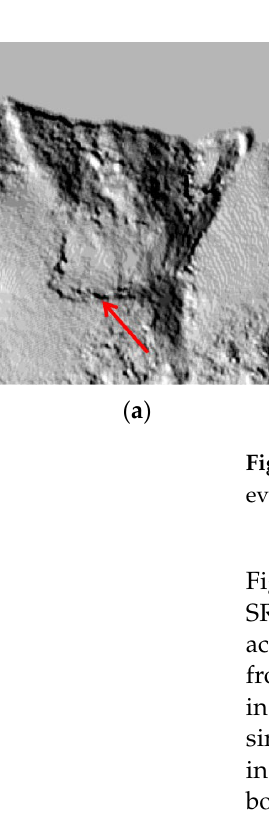
500600 Figure 14. Annual precipitation level (in mm) according to Sektagli meteorological data. A connection between the intra-annual displacement rates and the level of precipita- tions is illustrated in Figure 15. Increased movement rates measured on the interferograms -15 June 2016–13 July 2016 and 22 March 2017–15 November 2017 (last two points in Figure 10) may be ex- plained by the fact that the respective periods between acquisitions of the images, consti- tuting interferometric pairs, explicitly cover summer seasons with intensive rainfalls (red lines with numbers 1 and 2, respectively, in Figure 15). Short rainy interval 1 in the sum- mer of 2016 is an interval between ALOS-2 observations on 15 June 2016 and 13 July 2016. Additionally, a long and rainy summer interval in the summer of 2017 is an interval be- tween ALOS-2 observations on 22 March 2017 and 15 November 2017. An arrow number 3 in Figure 15 marks the start of the Sentinel-1 SAR observations in winter 2016–2017 (left plot in Figure 7). An absence of any significant rainfall for about two months before the start of the data collection is probably the reason for the uniform rates of soil movement throughout the winter. At the same time, the following winter measurements started on 9 November 2017, very close to the end of summer rainfalls (ar- row number 4 in Figure 15). Water-rich soils that time demonstrate increased velocity here, up to 17 cm per month; the velocity gradually decreased during the next two months to the average typical values of 4–5 cm per month at the end of winter because of the depletion of the excess soil moisture (right plot in Figure 7).